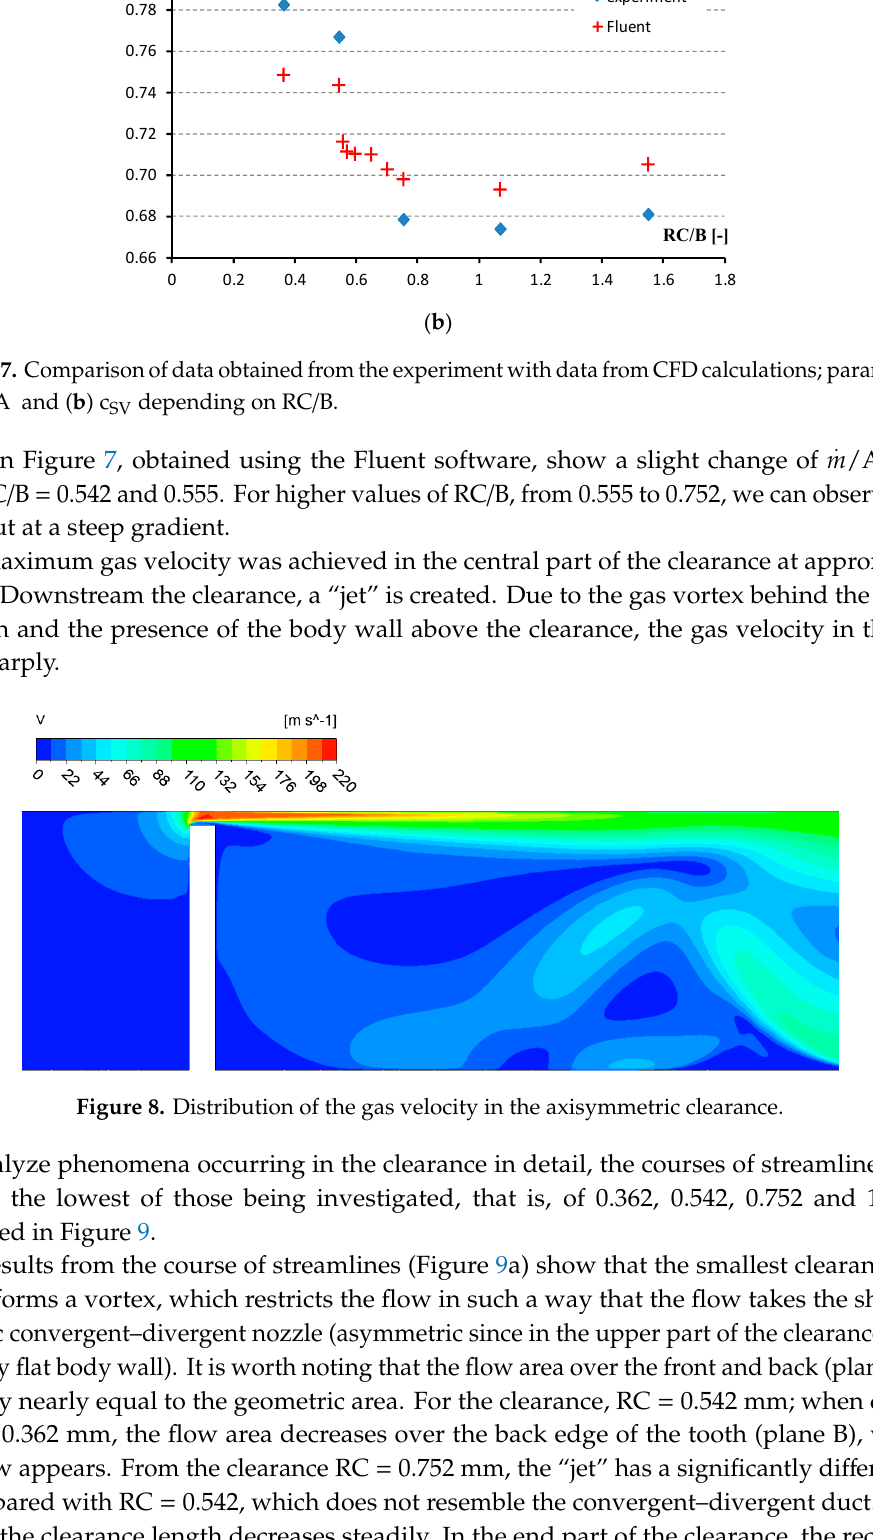
Figure 8. Distribution of the gas velocity in the axisymmetric clearance.